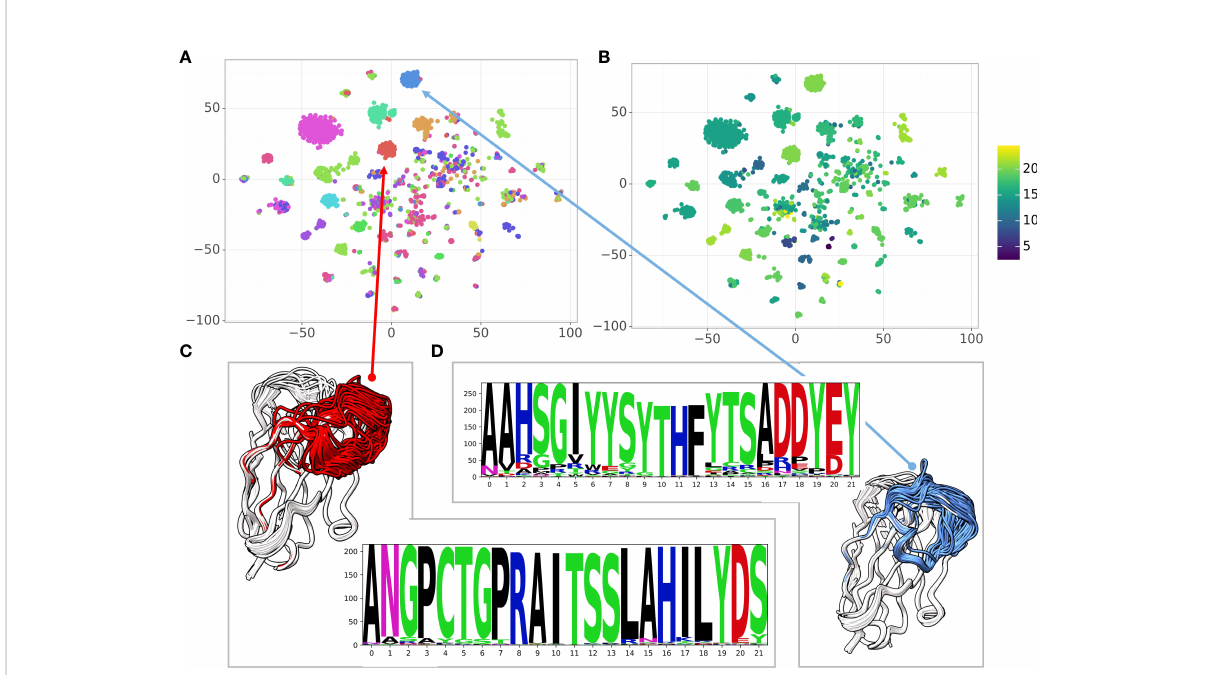
FIGURE 5 Correlating sequence and structure similarity. (A) The t-SNE sequence embedding colored by the structural cluster number (12 clusters), (B) The t-SNE sequence embedding colored by the CDR3 length, (C, D) Examples of structural clusters and their multiple sequence alignment, CDR3 is colored by the cluster color in the t-SNE sequence